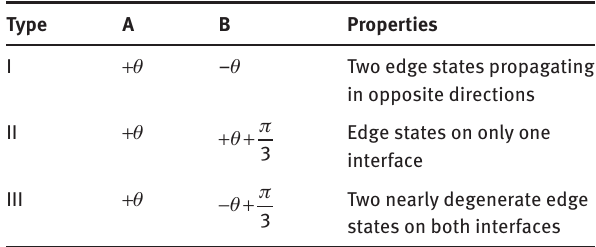
interfaces: summary of the different interface types, Table 1: C 3 v including the perturbations of regions A and B and properties of each edge